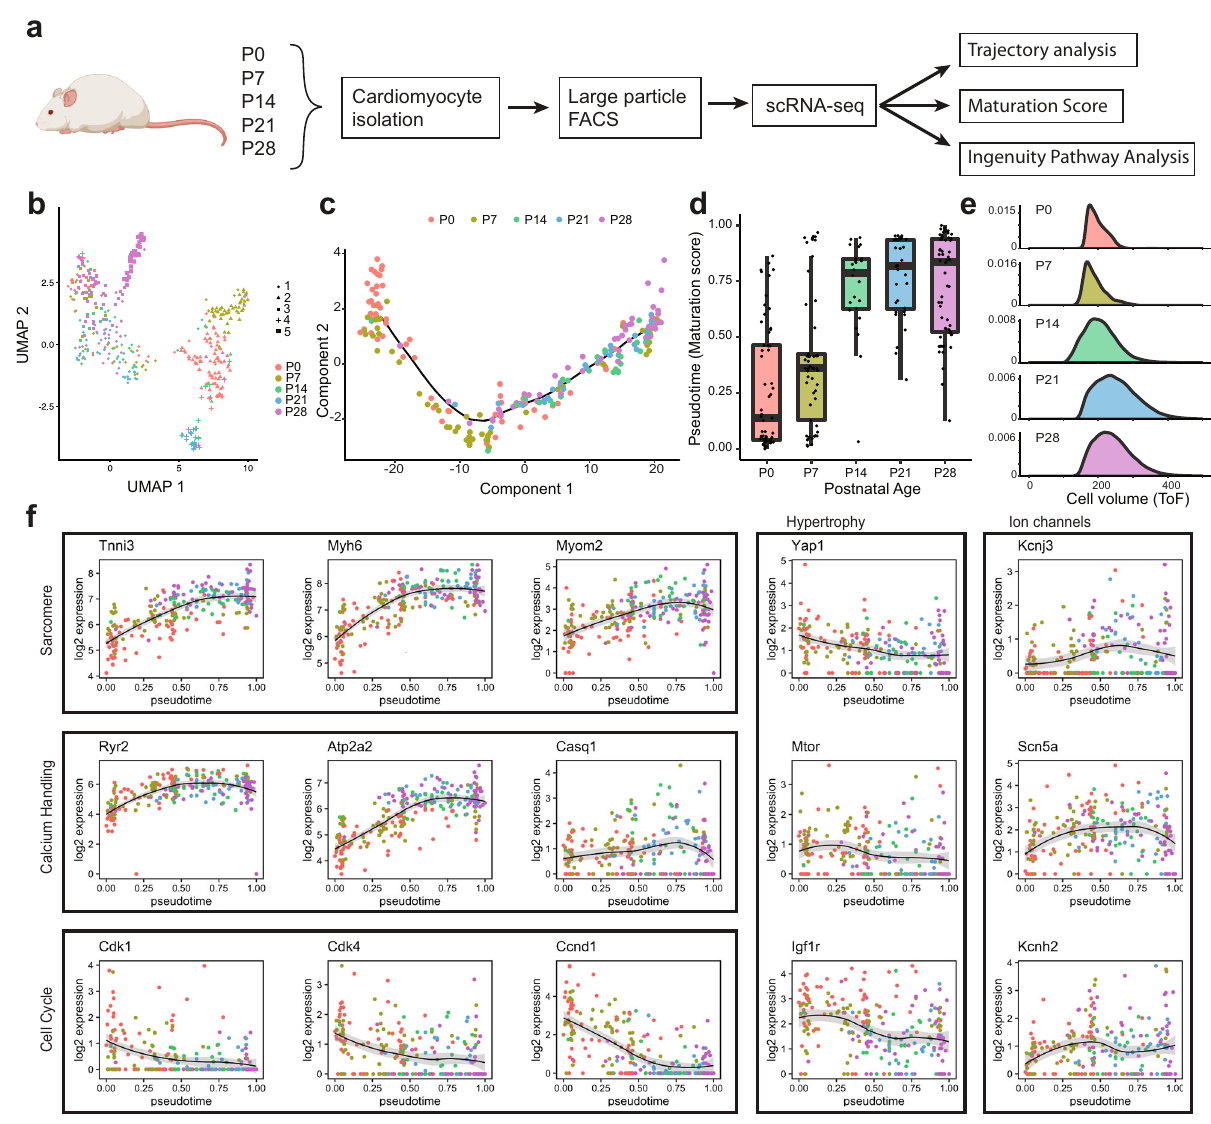
Fig. 1 Postnatal CMs exhibit high levels of transcriptomic heterogeneity. a Experimental design for scRNA-seq and computational analysis of CMs isolated from p0 – p28 hearts. 300 CMs were sequenced after quality cutoff. b UMAP plot representation of p0 (red), p7 (gold), p14 (green), P21 (blue), p28 (purple) CMs. c Monocle-based developmental trajectory of p0 – 28 CMs. d Distribution of normalized pseudotimes (maturation scores) by age. e LP – FACS-based cell size analysis with time of fl ight (ToF). ToF tracts the time it takes the cell to get from one measured point of the fl ow cell to another. f Log expression of CM genes associated with structural maturation, calcium handling, cell cycle, hypertrophy, and ion channels plotted over pseudotime. Error bands represent a 95% Con fi dence interval. Box-and-whiskers plot represents the maxima, 75th percentile, median, 25th percentile, and